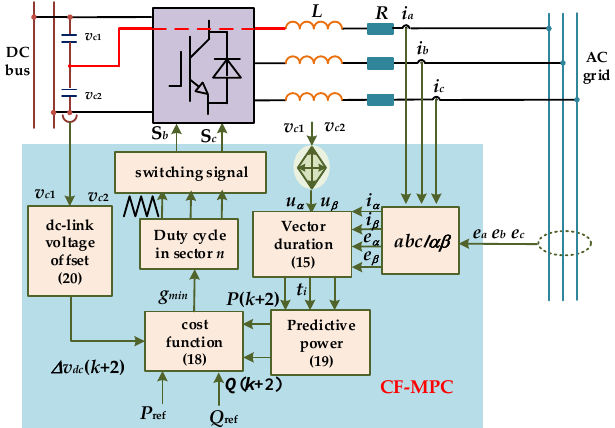
Figure 6. Constant-frequency model predictive direct power control (CF-MPDPC) structure for fault-tolerant BVSC.